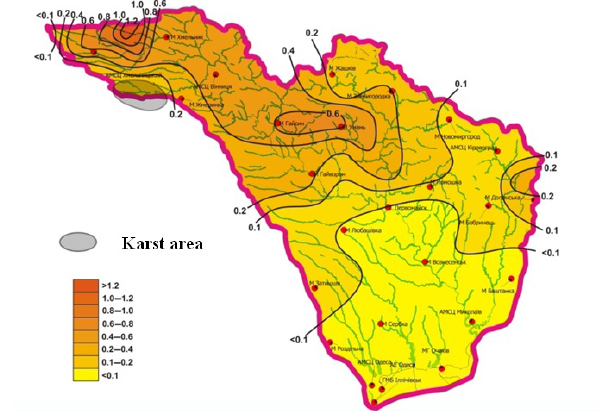
Figure 9. Distribution of 30d minimal runoff modules of 80% sup- ply for the period of open channel with stable freezing in the basin of the Southern Bug, L(skm 2 ) − 1